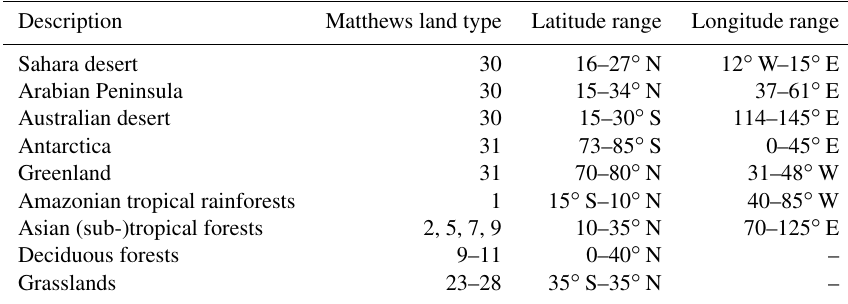
Table 2. Definition of the surface type regions studied in Fig. 7. The symbol “–” indicates that no constraint was set on the